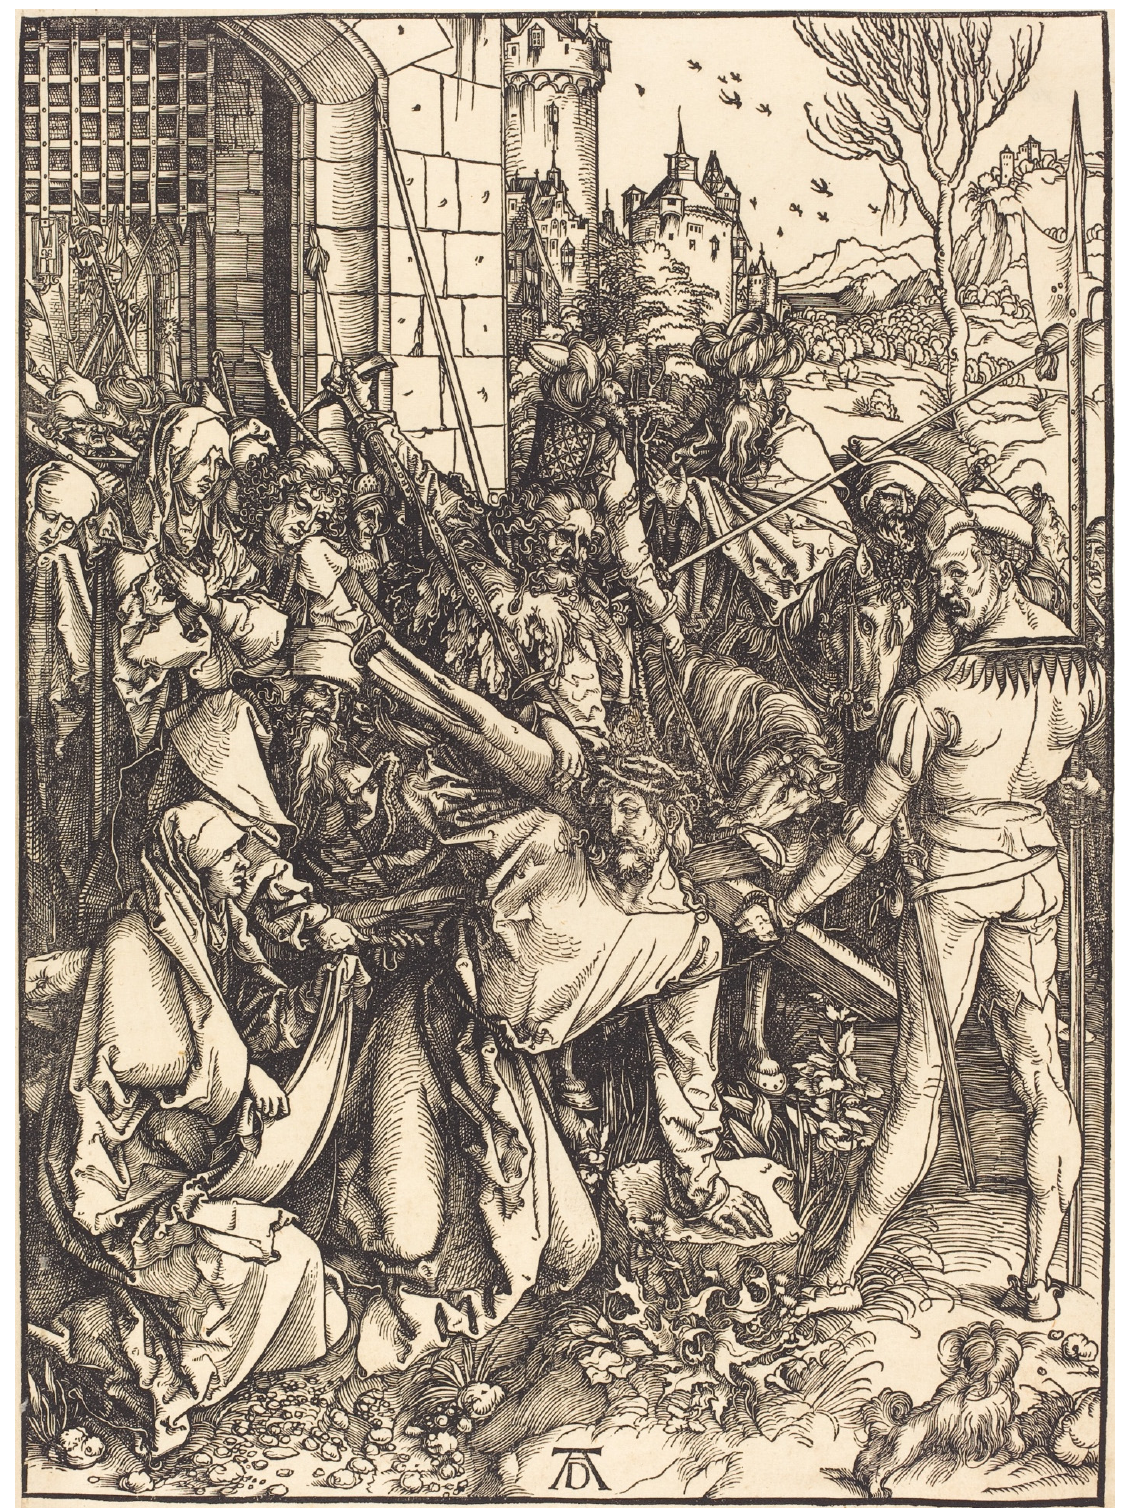
Figure 8. Albrecht Dürer, Christ Carrying the Cross from Large Woodcut Passion, ca. 1498–1499.